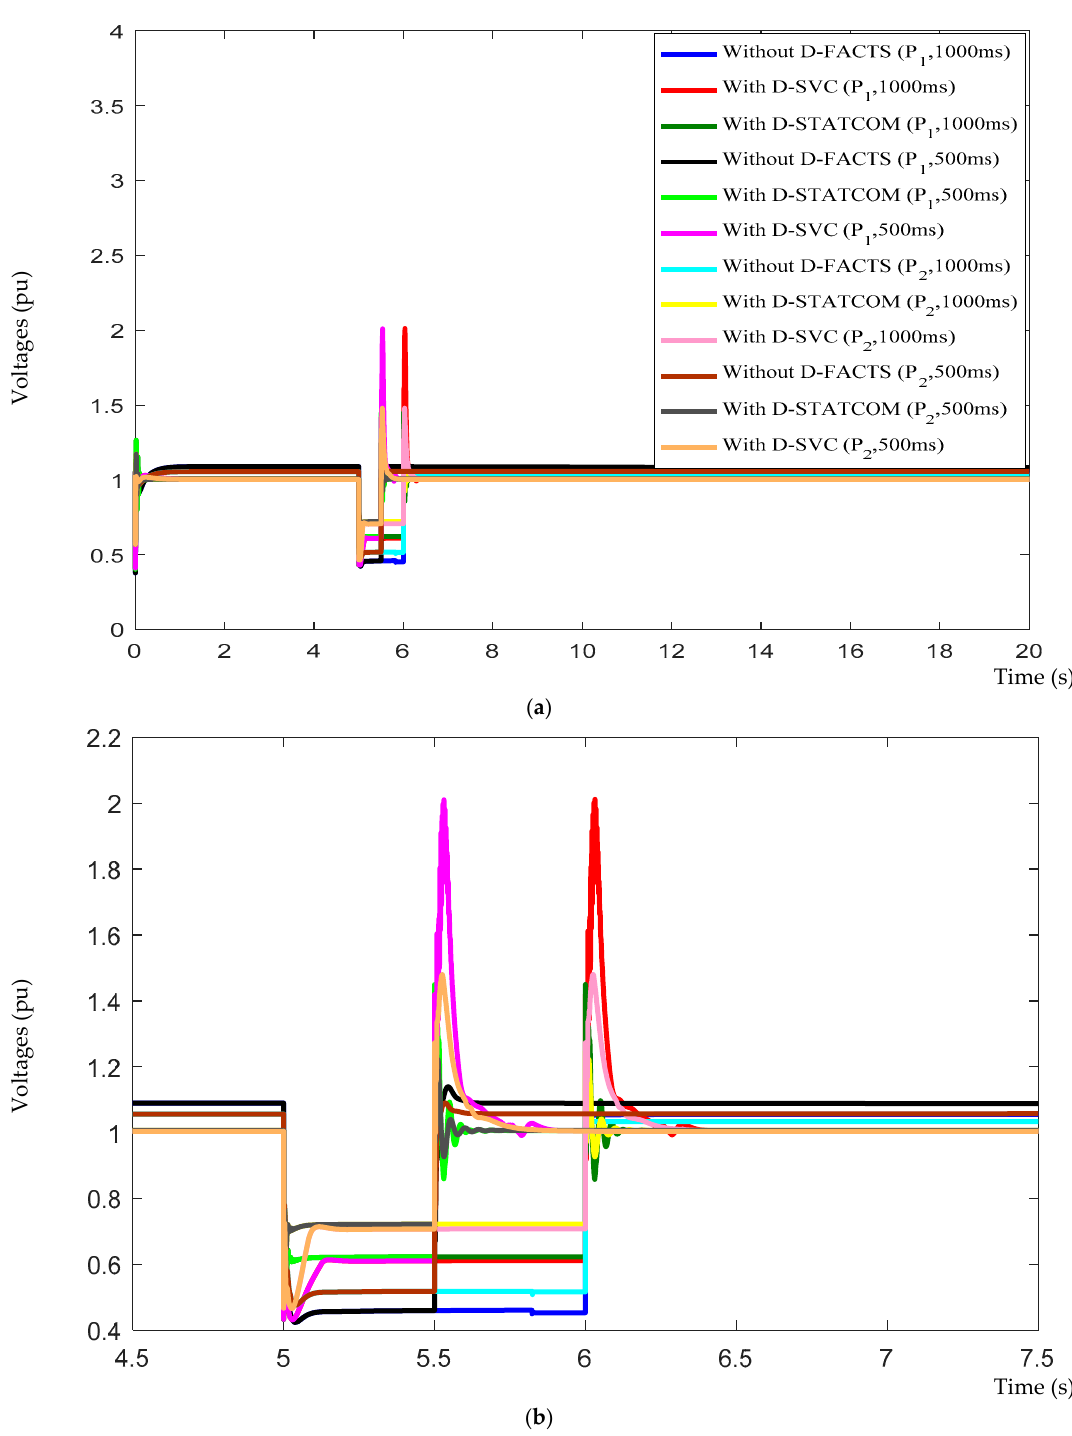
Figure 13. ( a ) Voltage at the PCC during line-to-line electrical grid fault; ( b ) zoom of voltage at the PCC during line-to-line electrical grid fault.